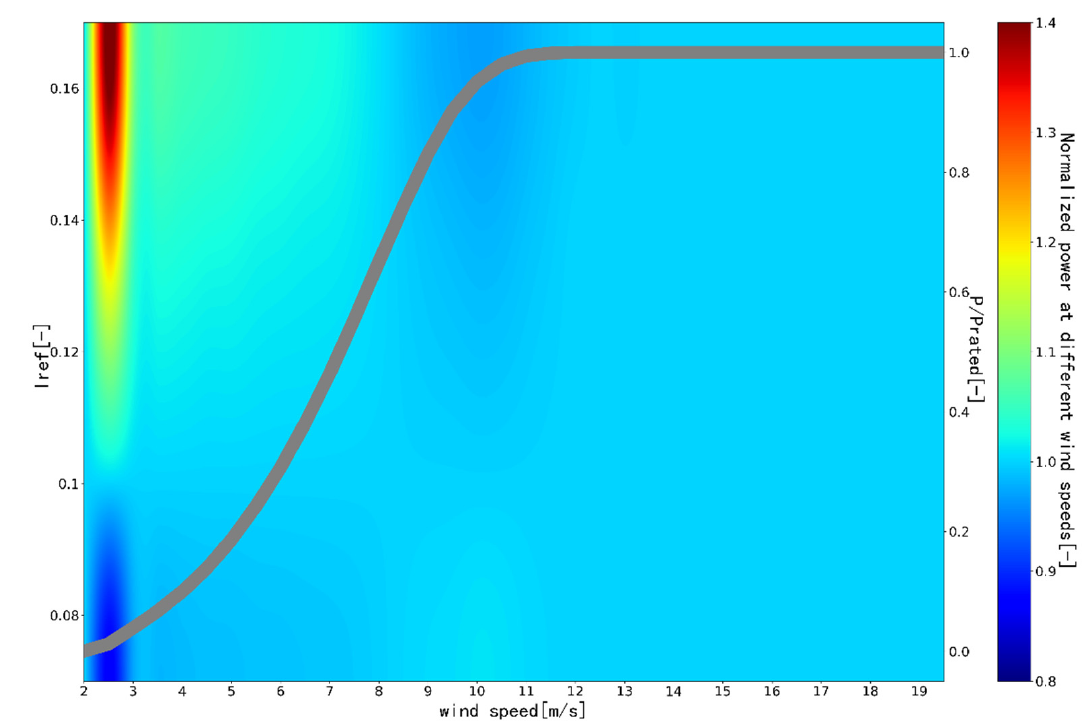
Figure 1. The effect of turbulence intensity on WTG OP at different wind speeds (Iref is reference value of the turbulence intensity defined by IEC 61400-1:2019 [23], color axis = normalized power at different wind speeds).